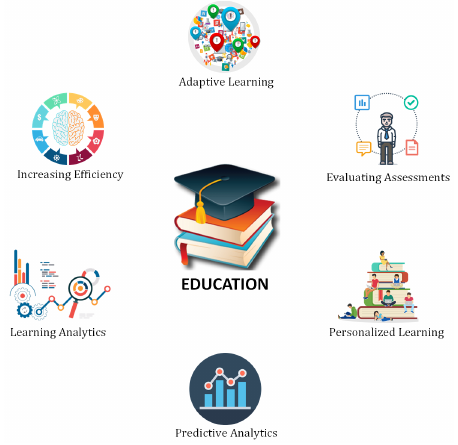
Figure 14. Applications of DL in education. Table 3. State-of-the-art contributions in DL-based educational